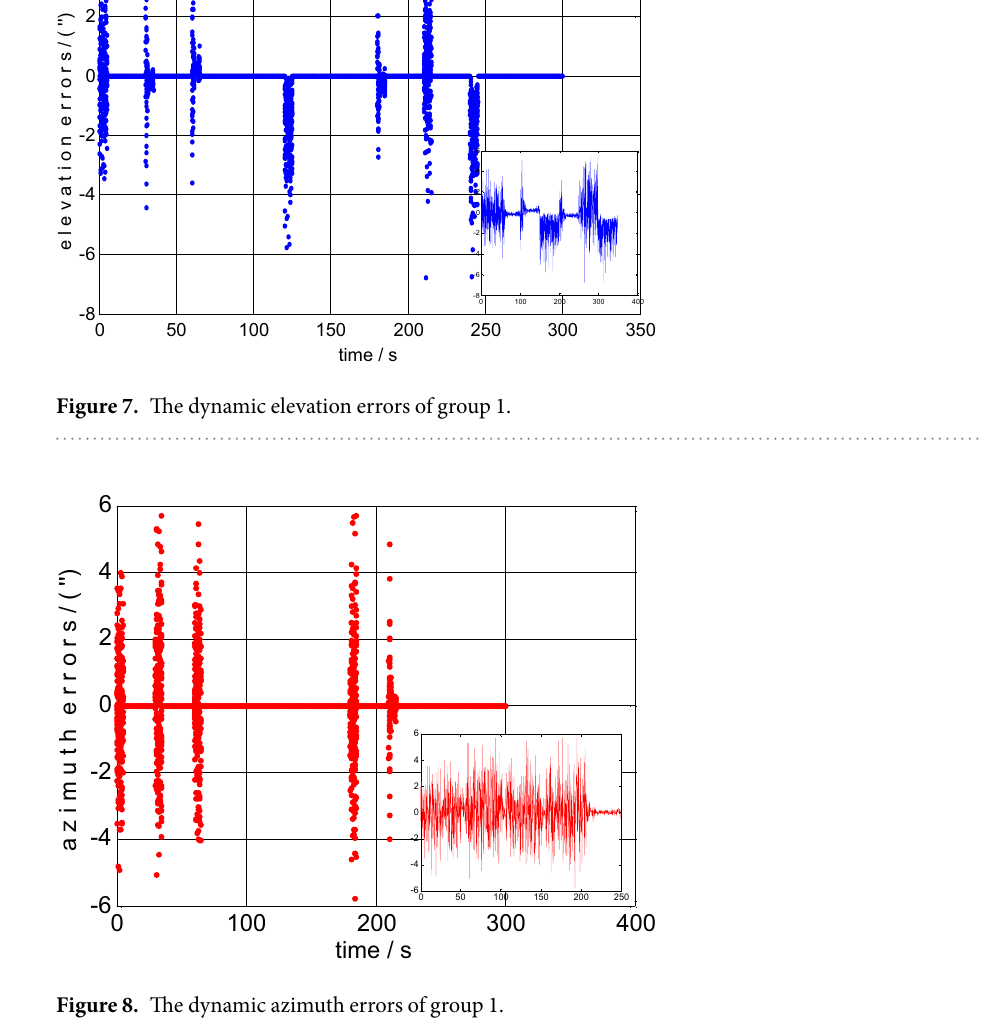
Figure 8. The dynamic azimuth errors of group